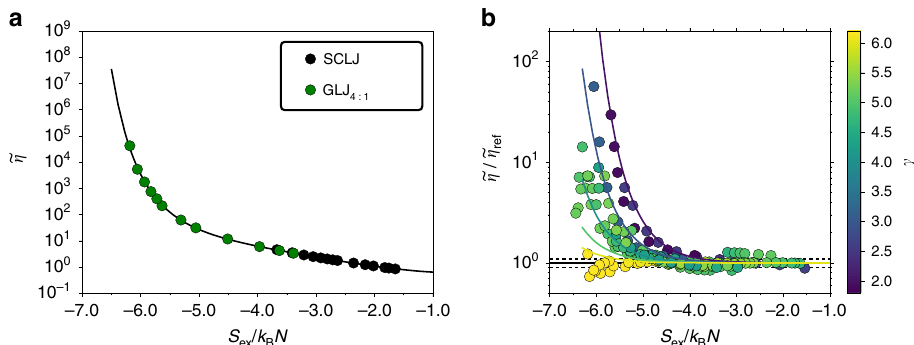
given by Eq. (5) based upon viscosity data for the SCLJ and 4:1 GLJ systems. Fig. 7 Accounting for the departure from universality. a Reference curve e η ref b Ratio of viscosity data for all binary mixtures to that obtained from the reference curve, colored by the value of γ . The dashed lines indicate the values 0.9 and 1.1, and the colored lines are the isolines γ = (2, 3, 4, 5, 6) [see Eq. (7) in text].